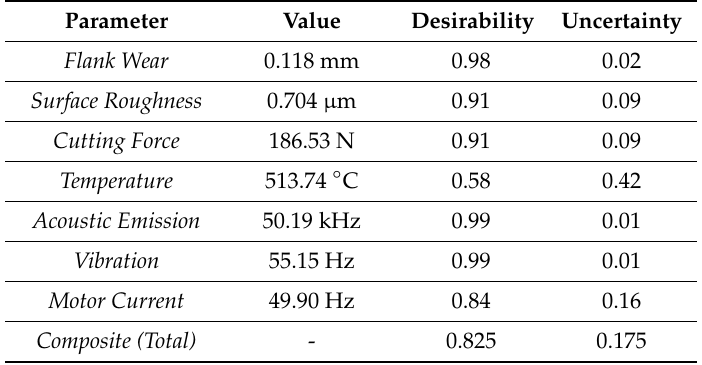
Table 7. Predicted responses with response surface methodology and desirability coe ffi